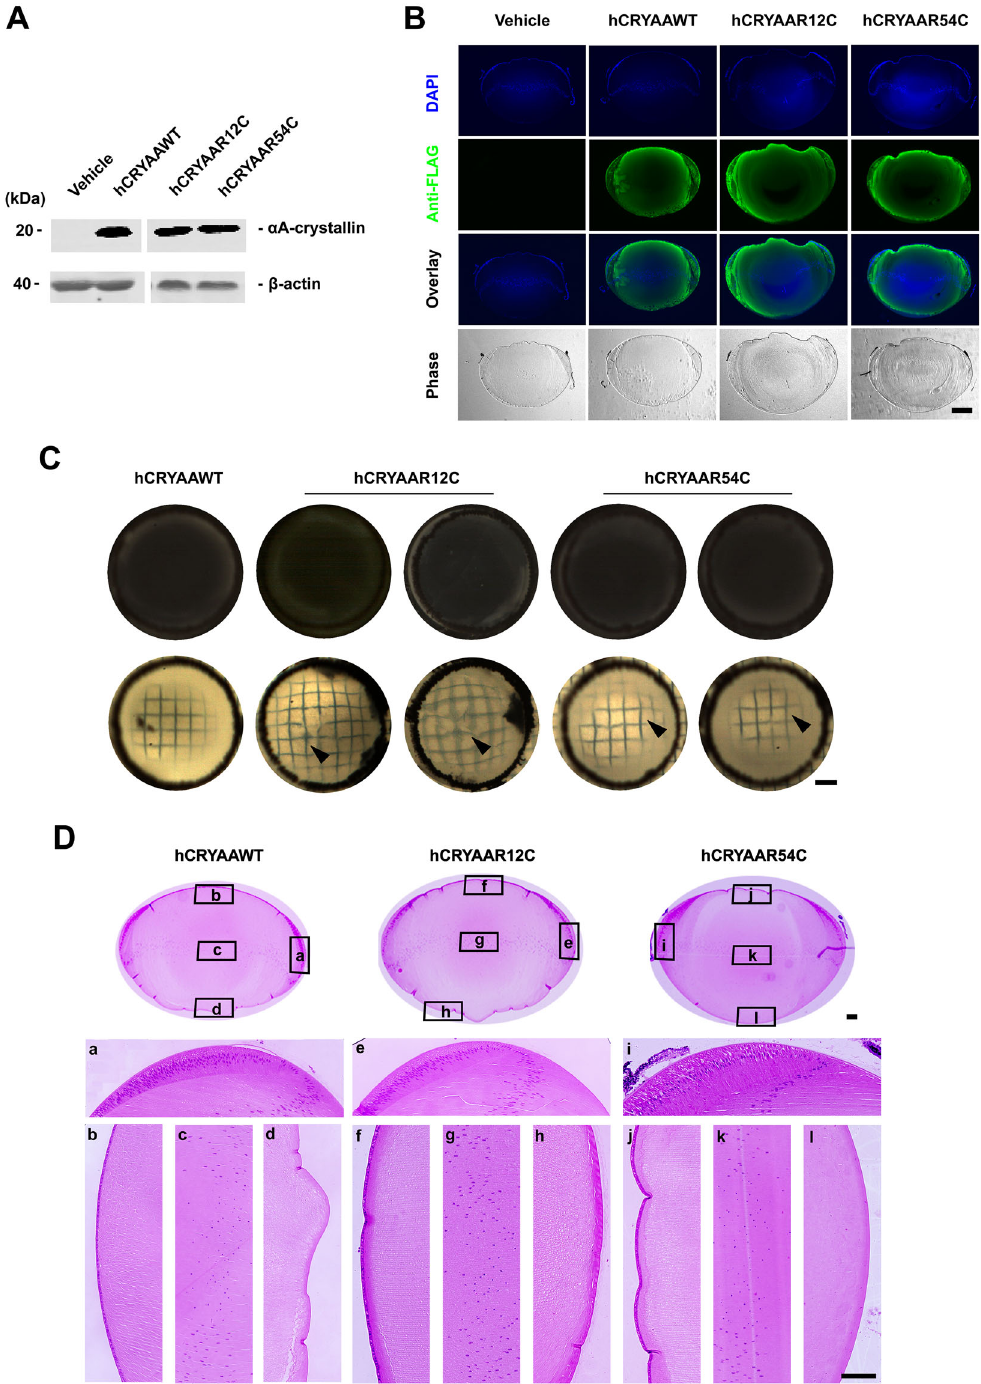
Fig. 7 Human crystalline mutations alter the light transmission of the lens. Embryonic chick lenses were injected with recombinant RCAS(A) expressing WT human α A-crystalline, hCRYAA, and two mutations, hCRYAAR12C, and hCRYAAR64C. Lenses were then isolated at E14 and E20. A Lens lysates were prepared and immunoblotted with anti-FLAG or anti- β -actin antibody. Scale bar: 400 µ m. B Paraf fi n sections of E14 chick lenses were prepared and immunolabeled with anti-FLAG and counterstained with DAPI. Scale bar: 400 µ m. C Dissected whole E20 chick lenses expressing exogenous WT hCRYAA or one of two mutations were imaged with a dissecting microscope with a black (upper panel) or grid background. D The midsagittal paraf fi n sections of various E20 chick lenses were stained by H&E. Images were captured at a lower resolution for the entire lens and higher resolution for various regions of the lens. Scale bar: 50 µ